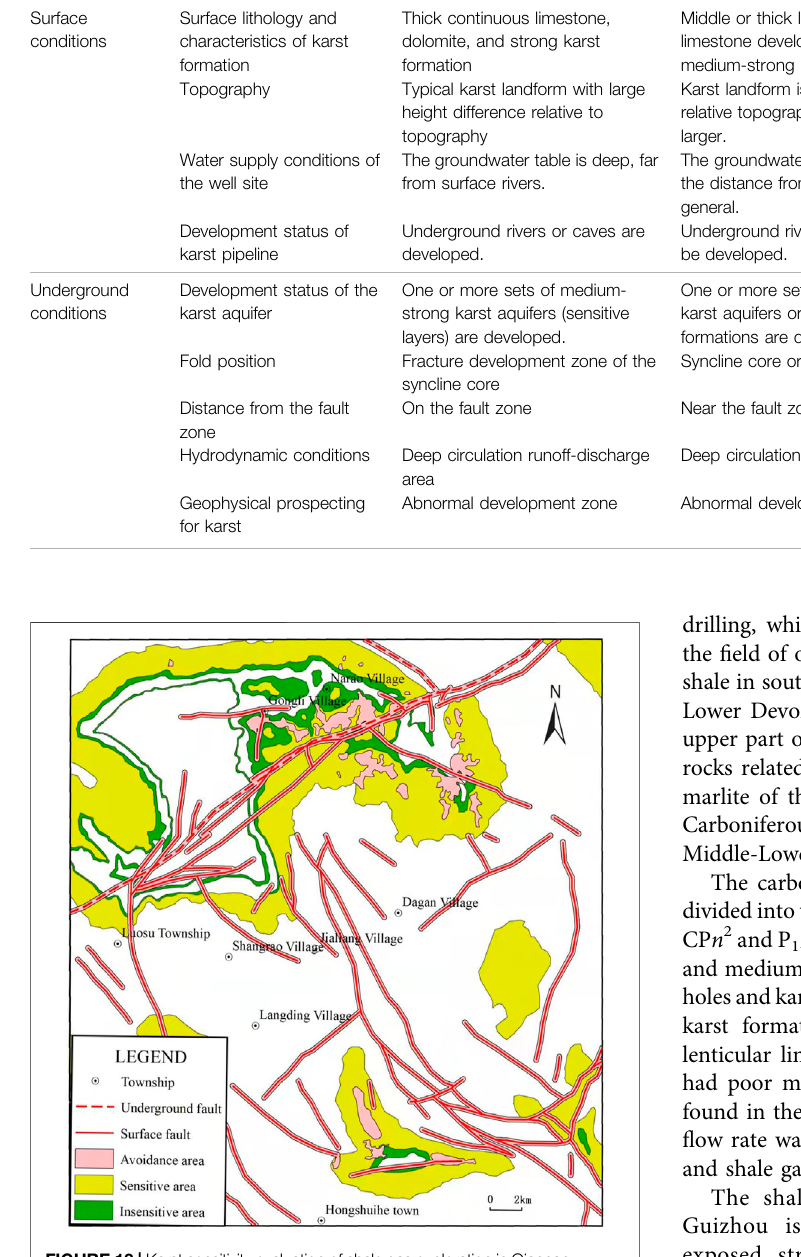
FIGURE 13 | KarstsensitivityevaluationofshalegasexplorationinQiannan area (Note: Surface faults were drawn based on regional geological maps, and underground faults were drawn based on seismic data